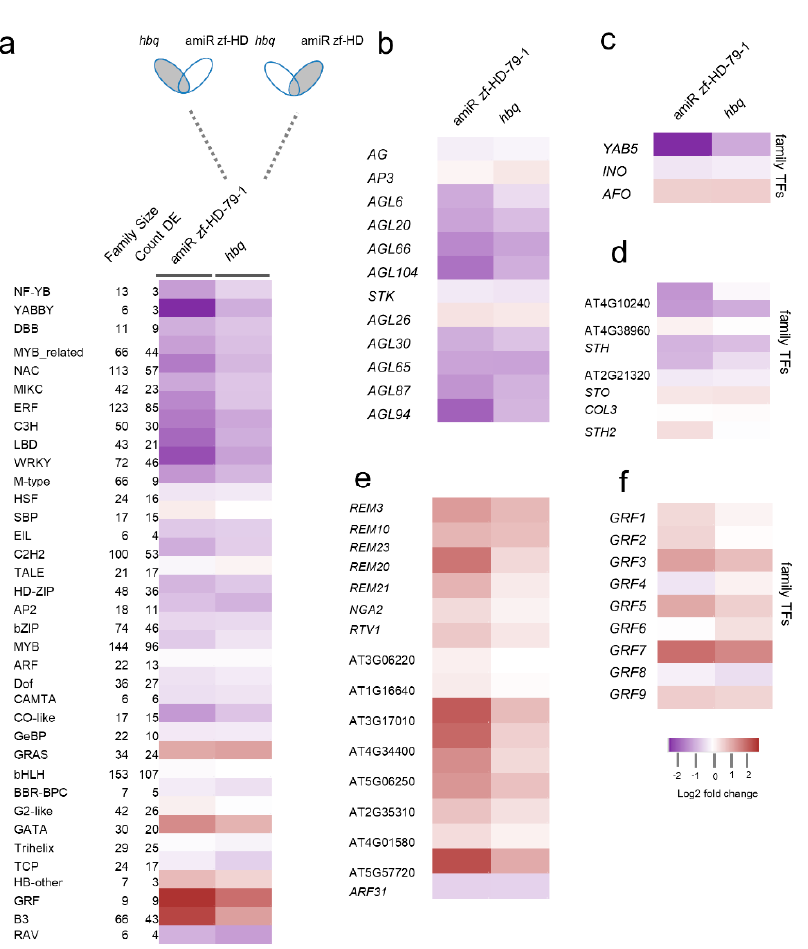
Figure 3. Heat map of TFs differentially expressed in young floral tissue in comparison with WT, as classified by TF family. ( a ) Expression profile of genes, grouped by TF families. The Venn diagrams above the columns are shaded gray to indicate the co − occurrence of differentially expressed genes in response to amiR zf-HD and to hbq mutants. Three biological replicates were used for RNA-seq. From left to right: genes DE in amiR zf-HD and hbq ; in amiR zf-HD and hbq ; in hbq ; and in amiR zf-HD. ( b – f ) Individual TF family genes with altered expression patterns in zf - hd mutants: ( b ) MIKC and M − type (MADS − box) TFs, ( c ) individual (YABBY) TFs, ( d ) double B − box zinc finger (DBB) TFs, ( e ) B3 TFs, and ( f ) GROWTH − REGULATING FACTOR (GRF) TFs. Three biological replicates were used for